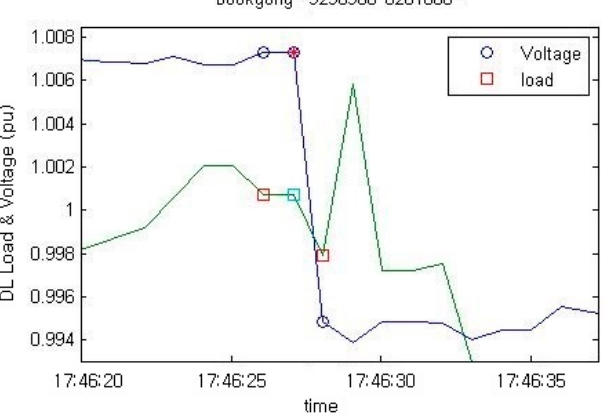
Figure 5. Load and voltage of the Bookgong D/L: details at the moment of tap change.